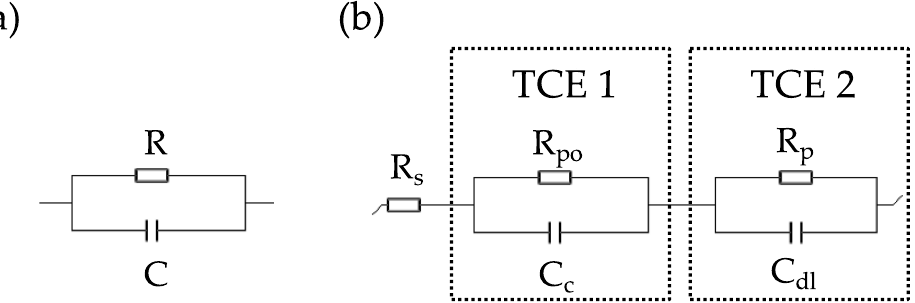
Figure 8. ( a ) A time constant element (TCE) composed by a resistor R with a capacitor C in parallel. ( b ) A two-time constant equivalent circuit, commonly used in this study: the electrolyte resistance is in series to a first TCE that models the polymer|electrolyte interface, and to a second TCE for the metal|solution interface.